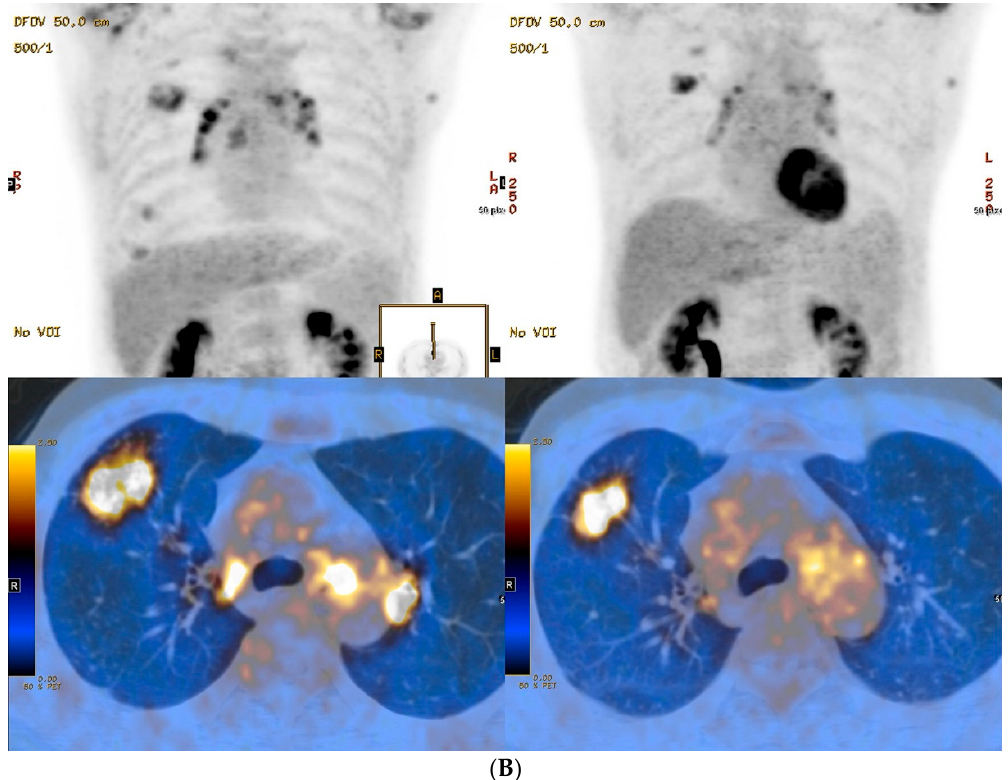
Figure 1. PET/CT images of lungs from two MDR-TB patients. Baseline (left column) and 12 months follow-up (right column) maximum-intensity projection and transverse fusion PET/CT images of patient 2 ( A ) and patient 4 ( B ). ( A ) Images of patient 2 show multiple hypermetabolic lesions in the right lung at baseline that disappeared in follow-up images despite persistent disease. ( B ) Images of patient 4 show multiple hypermetabolic lesions in the right lung at baseline that improved but were persistent in follow-up images irrespective of negative culture conversion and treatment success. Total metabolic lung volume (92.3 cm 3 ) and total lung glycolysis (307.3 cm 3 ) in patient 2 using a baseline PET/CT were much higher than for patient 4 (4.6 cm 3 and 14.1 cm 3 , respectively).